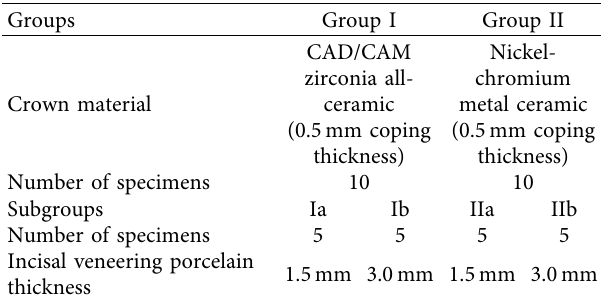
Table 2: Grouping of the specimens.